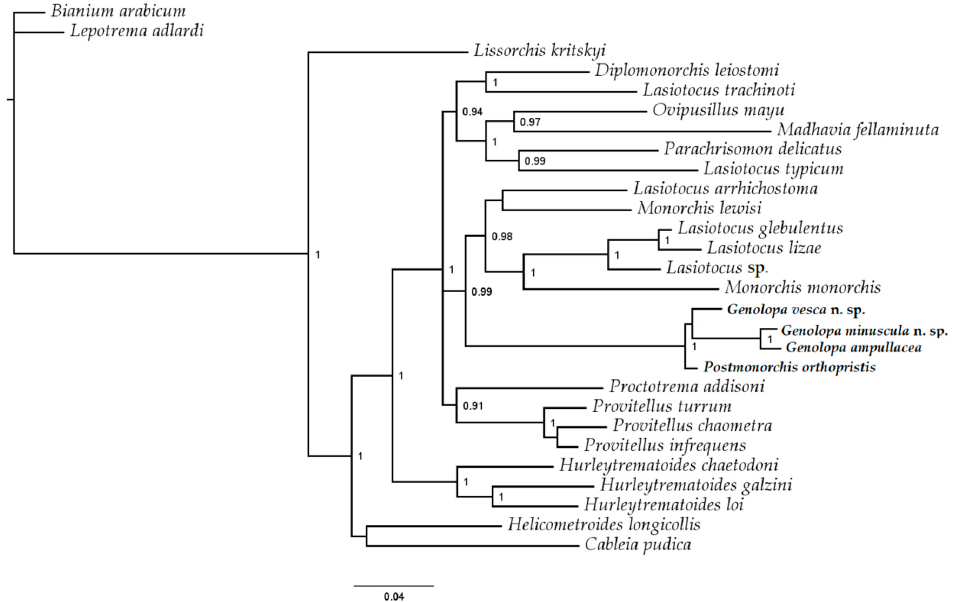
Figure 4. Interrelationships among members of the Monorchiidae based on Bayesian inference analysis of partial 28S rDNA data. Bayesian inference posterior probabilities are shown at the nodes; support values < 0.85 are not shown. Genolopa – Postmonorchis clade highlighted with bold text. Importantly, the present phylogeny supports that Genolopa is a distinct lineage from Lasiotocus, Parachrisomon, and Proctotrema at the generic level. Pairwise comparisons of variable sites of the 28S rDNA gene among species of Genolopa and Postmonorchis are presented in Table 3. Sequences of G. minuscula n. sp. and G. ampullacea differed by 1.6% (19 bp). Sequences of G. vesca n. sp. and both G. minuscula n. sp. and G. ampullacea differed by 4.9% (57 bp). The sequence of P. orthopristis differed the least with G. vesca n. sp. by 2.1% (24 bp). Sequences of P. orthopristis and G. minuscula n. sp. di ff ered by 3.9% (45 bp), and sequences of P. orthopristis and G. ampullacea di ff ered by 4% (47 bp). Table 3. Pairwise comparison among partial fragments (1163 base pairs long) of 28S rDNA from species of Genolopa and Postmonorchis in present study, shown as number of variable sites with (%) (above diagonal). Species G.